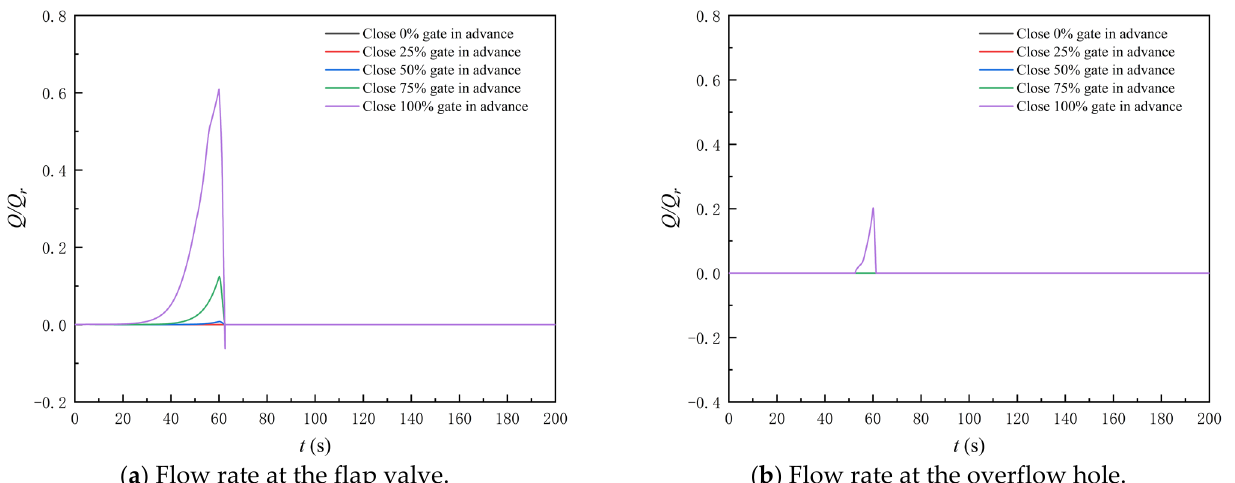
Figure 17. Flow at the flap gate and overflow hole when the different gate closing schemes were adopted (TTGC: 60 s).